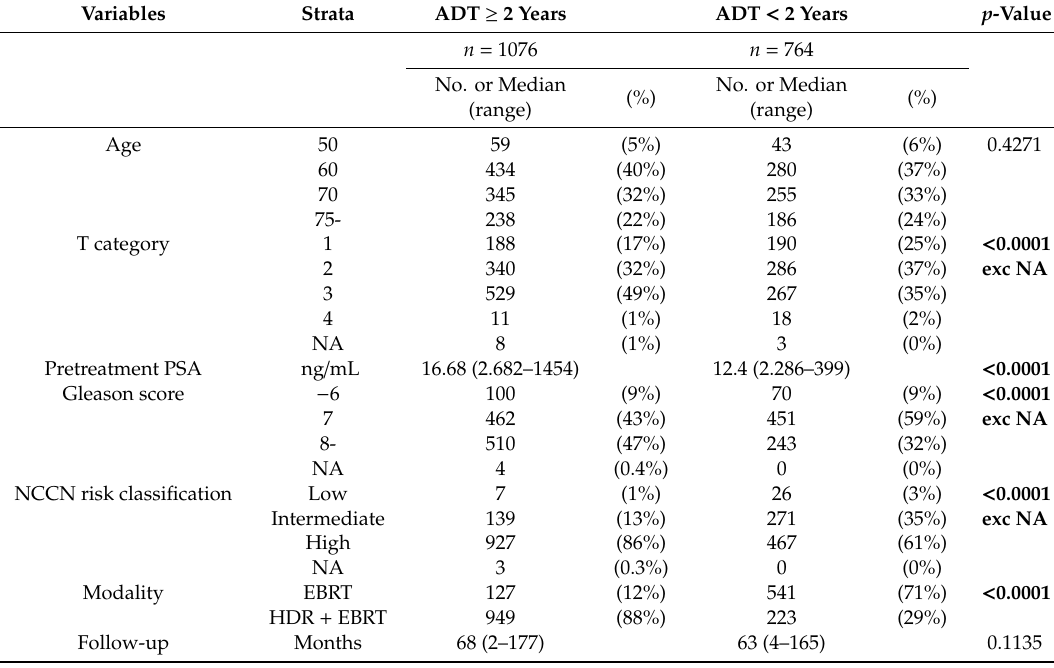
Table 1. Characteristicsandtreatmentfactorsofpatientsaccordingtoandrogendeprivationtherapy(ADT).